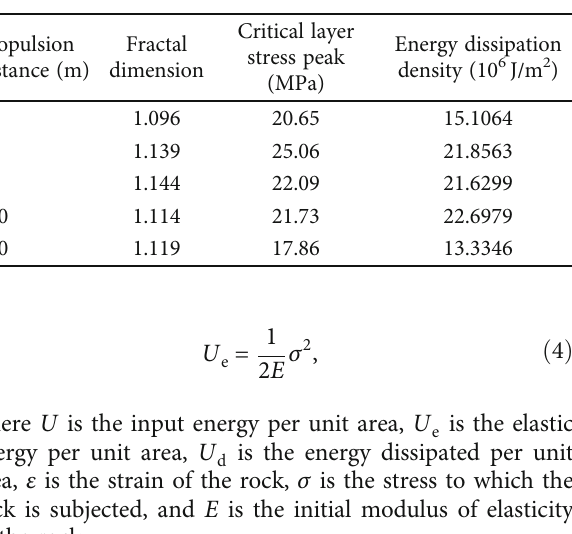
Figure 4: Relationship between peak stress and fractal dimension. Table 4: Fracture development